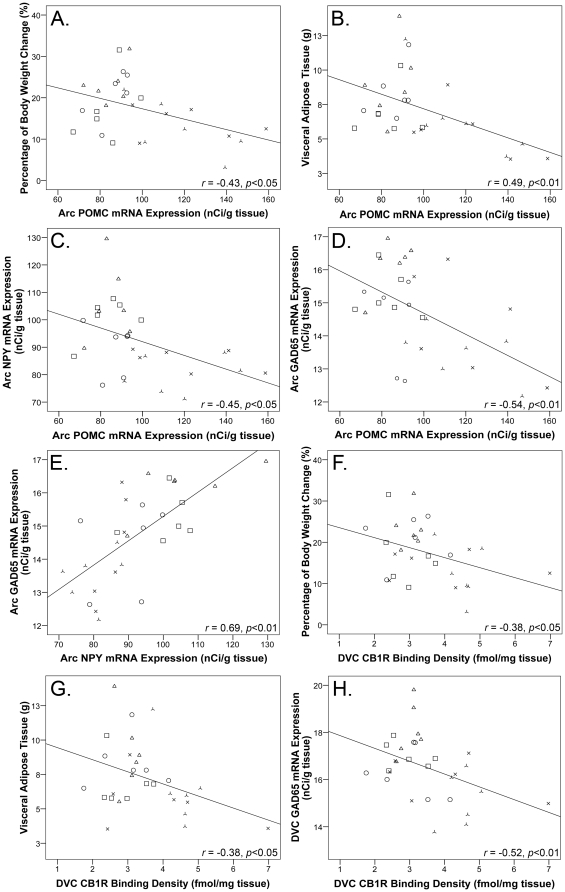
Correlations.Correlations between pro-opiomelanocortin (POMC) mRNA expression in the arcuate (Arc) nucleus and (A): percentage of body weight change, (B): visceral adipose tissue, (C): neuropeptide Y (NPY) mRNA expression in the Arc, (D): glutamic acid decarboxylase (GAD65) mRNA expression in the Arc, (E): Arc NPY and GAD65 mRNA expression, (F): cannabinoid CB1 receptor (CB1R) binding density in the dorsal vagal complex (DVC) and percentage of body weight changed, (G): DVC CB1R binding density and visceral adipose tissue, and (H): DVC CB1R binding density and GAD65 mRNA expression, following 14-days olanzapine treatment or vehicle (control). Correlation analyses were made from raw data underlying the graphs presented in Figures 1 and 3. Key: <$>\raster="rg1"<$> control, ×0.5 mg/kg, ○ 0.5 mg/kg, □ 1.0 mg/kg, ▵ 2.0 mg/kg olanzapine.